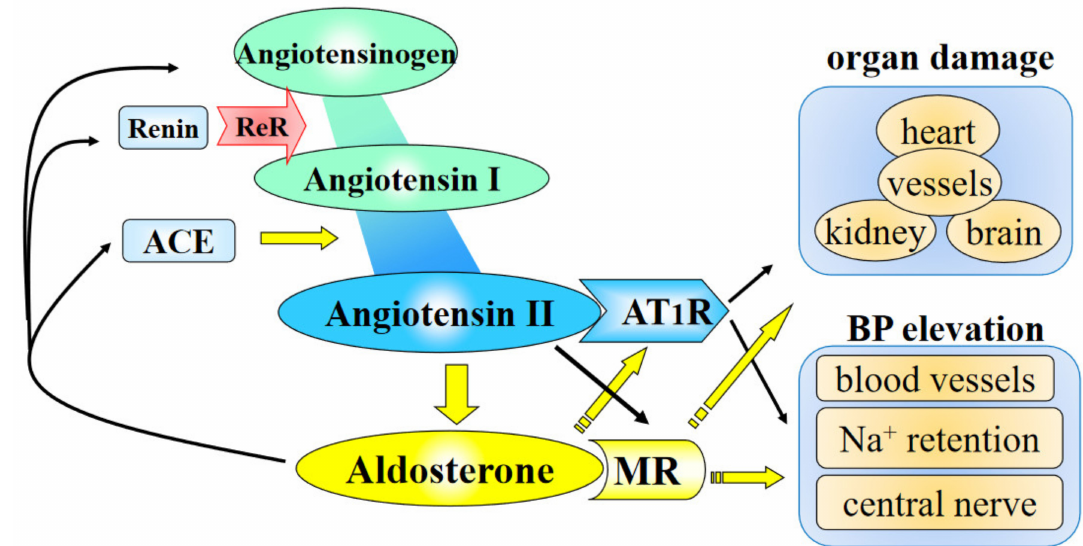
Figure 1. The cross-talk of angiotensin II and aldosterone in the pathogenesis of hypertension and cardiovascular diseases. Angiotensin II increases MR activity. Aldosterone affects not only AT1R but also ACE, renin and angiotensinogen. AT1R, angiotensin II type 1 receptor; MR, mineralocorticoid receptor; ACE, angiotensin converting